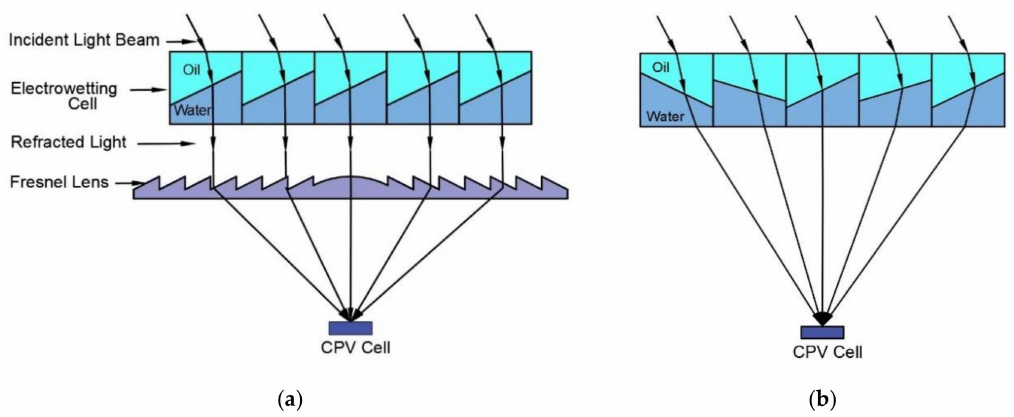
Figure 4. Steering and concentrating solar energy by electrowetting cell array on a CPV cell, ( a ) with a Fresnel lens, ( b ) without a Fresnel lens.